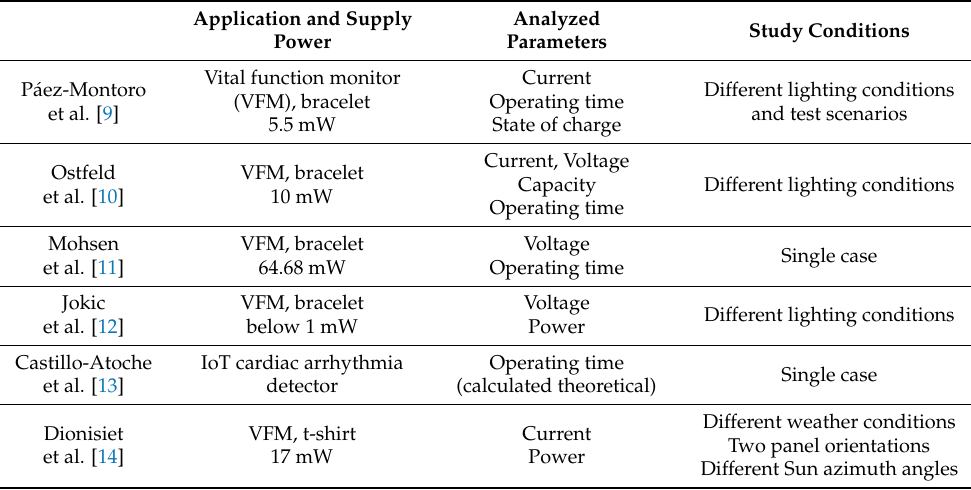
Table 1. State-of-the-art comparison